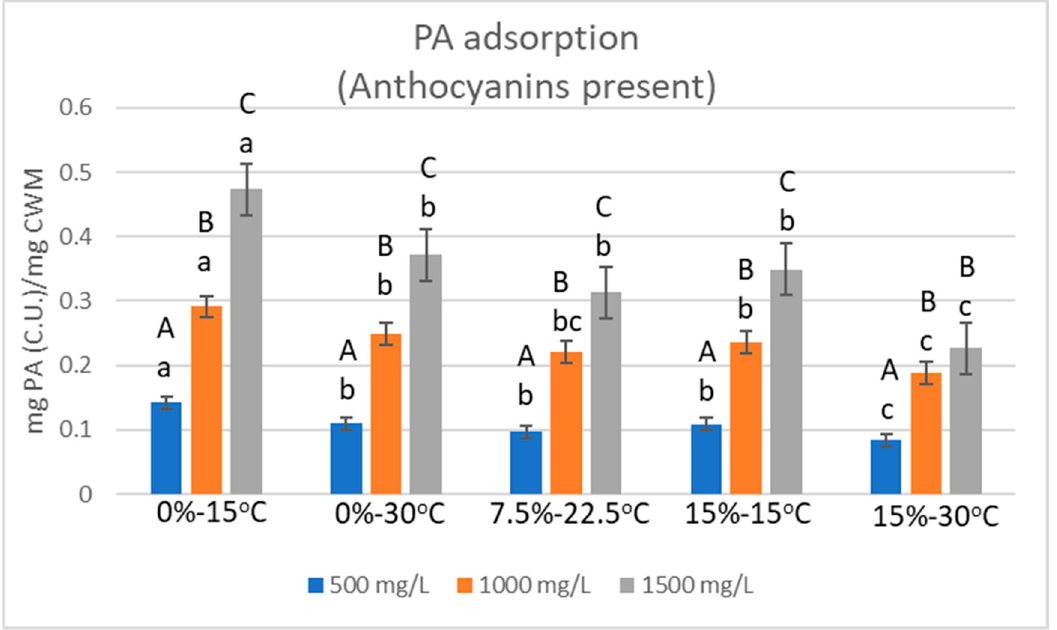
Figure 2. Average mass of PA adsorbed after 1440 min of contact with CWM relative to the mass of CWM ( n = 3). Capital letters = significant difference within the same EtOH–temperature condition. Lowercase letters = significant difference between EtOH–temperature conditions of the same starting PA concentration. Significant difference defined as p < 0.05.